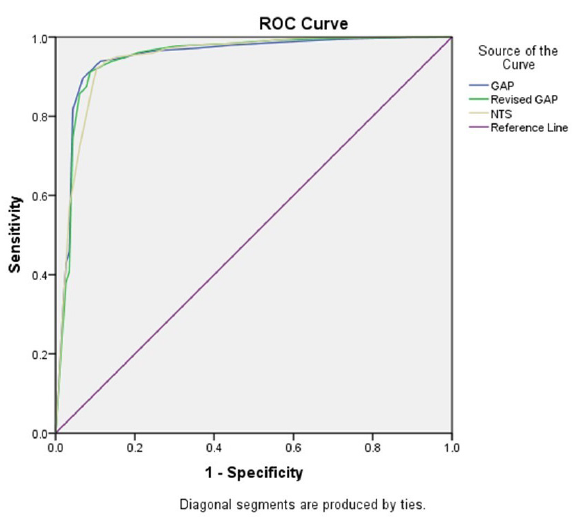
Figure 1. ROC curve of GAP, R-GAP, and NTS variables in predicting hospital survival.